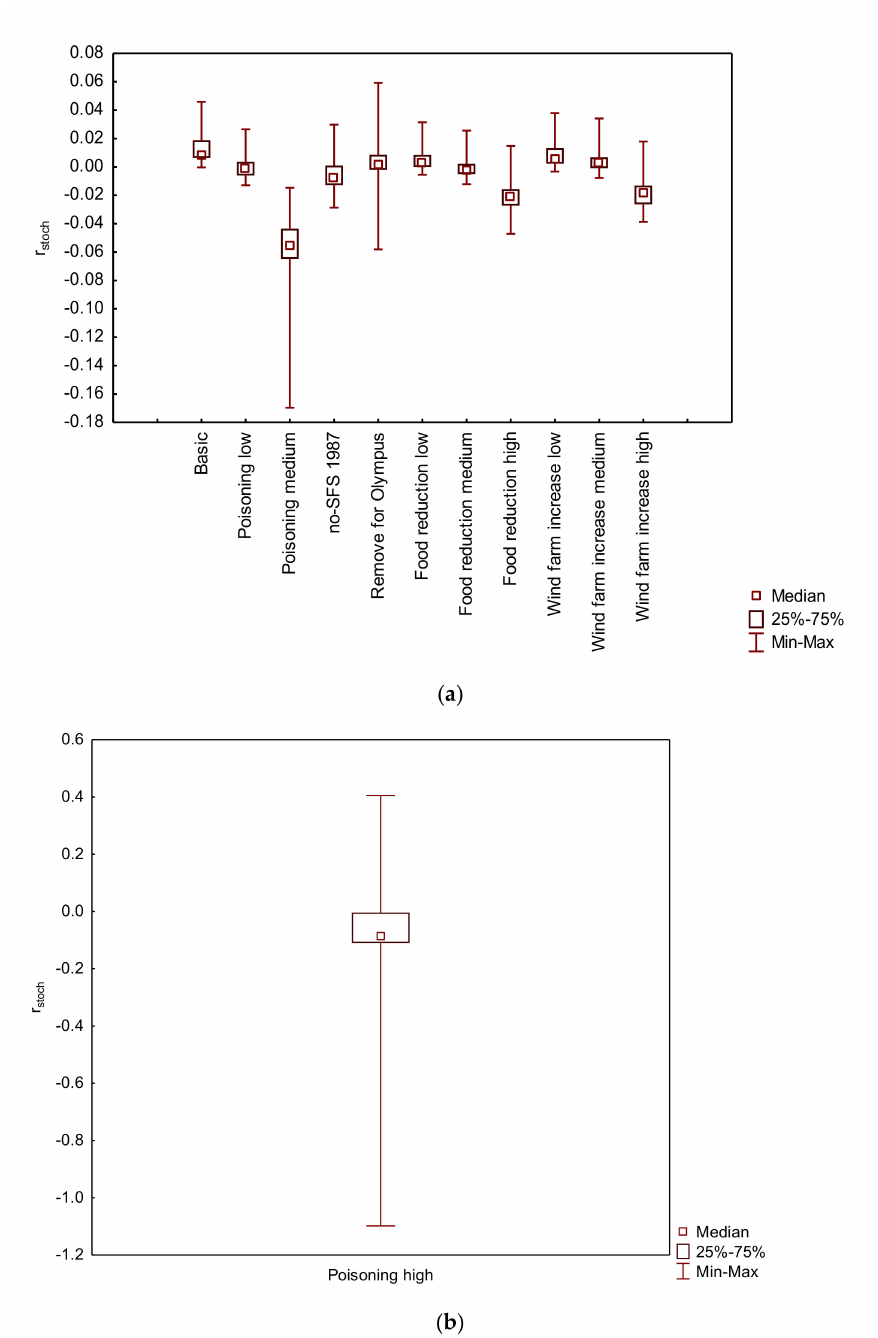
Figure 2. Comparative stochastic population growth rates (r stoch ) under different scenarios: ( a ) Basic and alternative scenarios and ( b ) High poisoning scenario, simulated (100 years) in a Population Viability Analysis in Southeast Europe for the Eurasian Black Vu lture ( Aegypius monachus